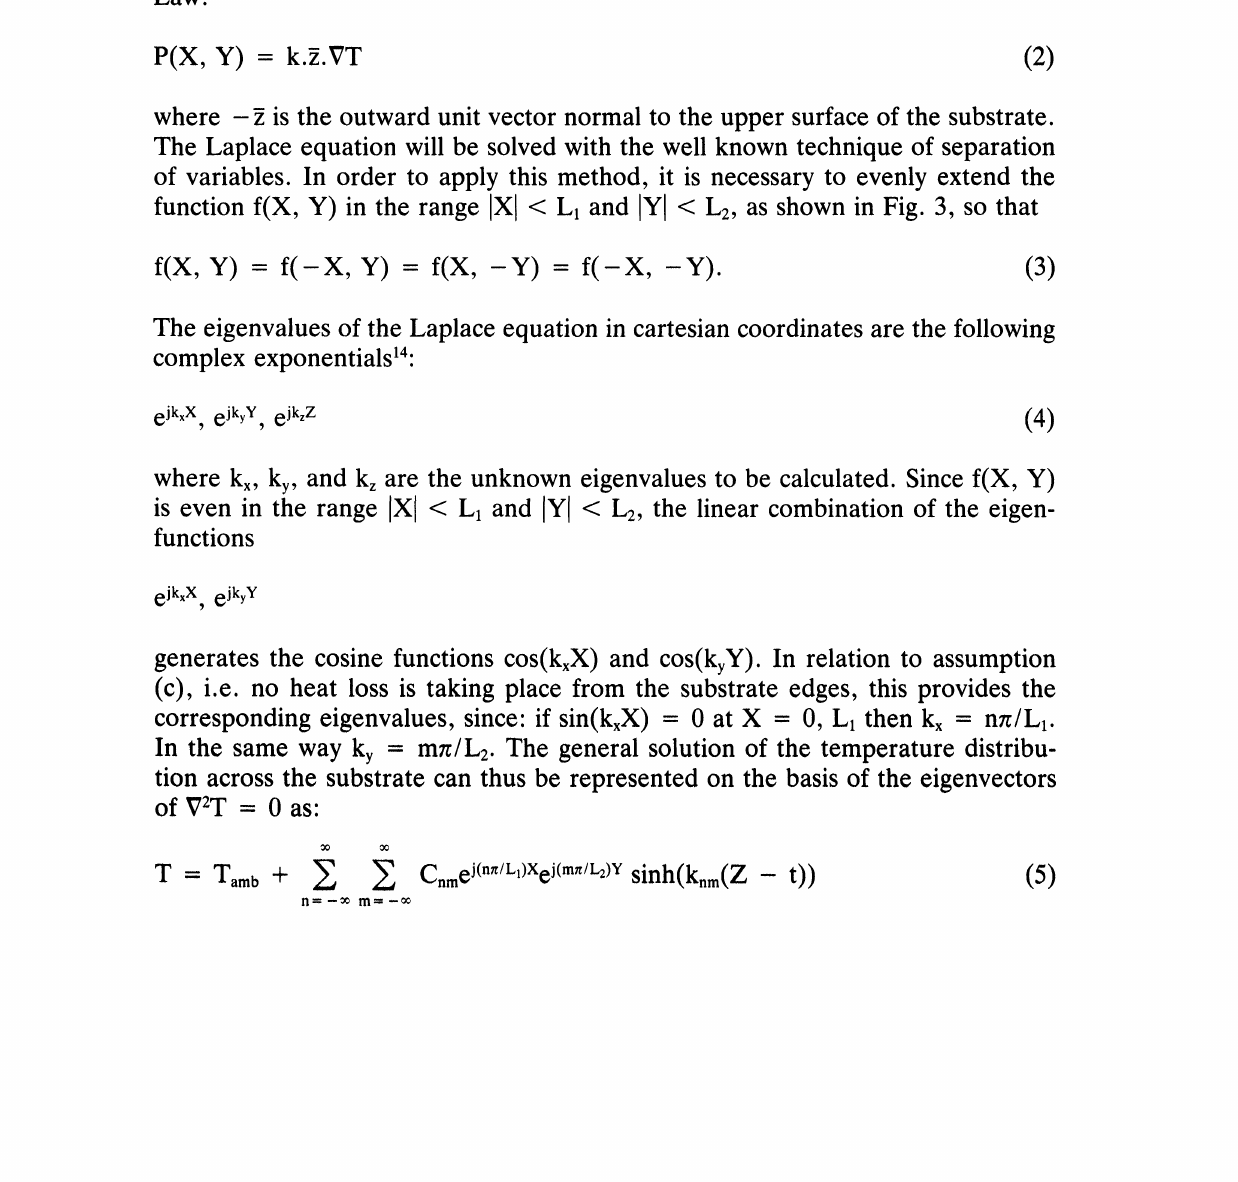
FIGURE 2 An arbitrary hybrid circuit (see text for